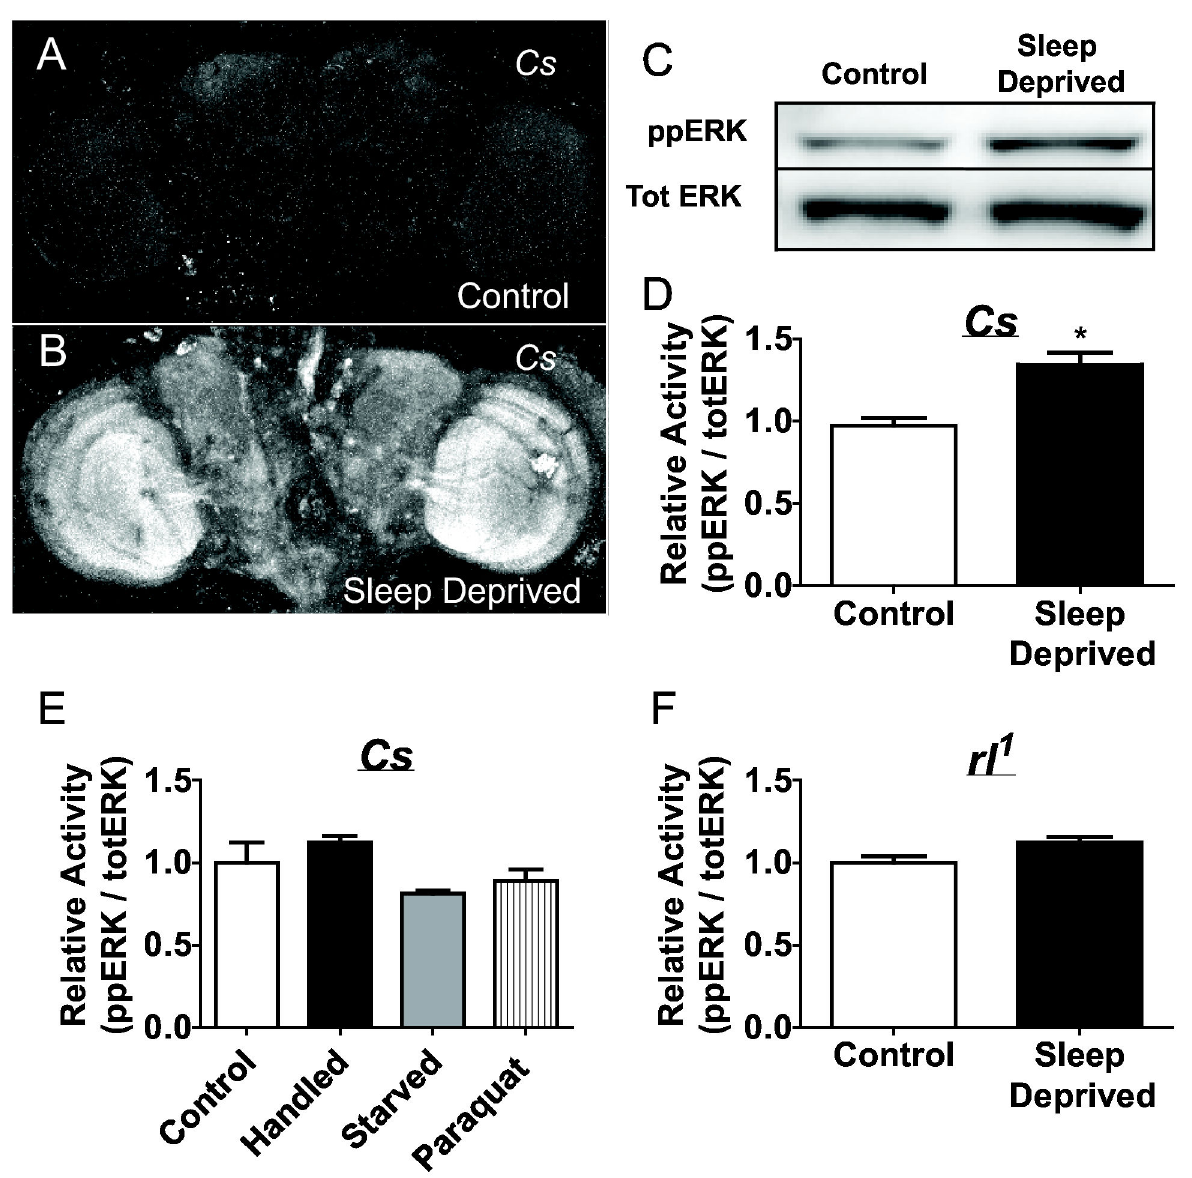
Figure 2. Sleep deprivation activates ERK. A - B , Immunohistochemistry of ppERK in brains from 5 day old Cs flies that experienced either a full night of sleep ( A ) or 12 hours of sleep deprivation ( B ). C , Western blot showing an increase in ppERK activation following 12 h of sleep deprivation in 5 day old Cs flies (4 heads/lane). D , Quantification of the Western blot in C revealed a statistically significant increase in ppERK/TotERK levels , p = 0.0059, student’s t-test, n= 4/group. Data are presented as mean ± SEM. E , Quantification of ppERK levels in wild type Cs flies exposed to mechanical perturbation (handled), the oxidative stressor Paraquat or starvation show no statistically significant differences in ppERK/total ERK levels compared to non-manipulated control flies p = 0.402, p = 0.477 and p = 0.209 respectively, student’s t-test, n = 3/group. Data are presented as mean ± SEM (* = p < 0.05). F , Quantification of the change in ppERK levels using Western blot in rl 1 mutant flies following 12 hours of sleep deprivation revealed no alteration in ppERK levels p = 0.0815, student’s t-test, n = 3/group. Data are presented as mean ± SEM. doi: 10.1371/journal.pone.0081554.g002 activate transcription, activated ERK translocates to the the nucleus, we performed western blots on nuclear fractions of nucleus where it activates downstream transcription factors. To fly heads exposed to sleep deprivation for 12 hours. We found test if sleep deprivation increased levels of activated ERK in that 12 hours of sleep deprivation resulted in an increase in